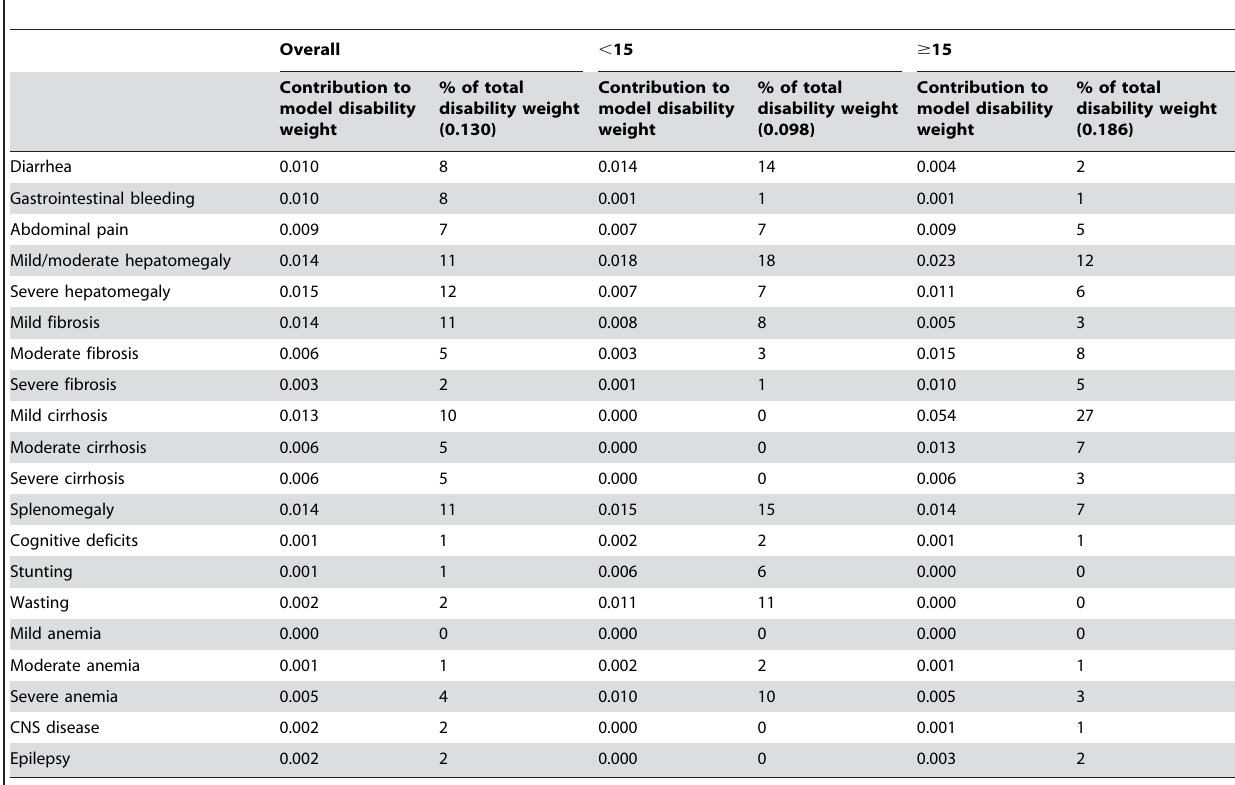
Table 2. Proportion of model disability weight attributable to each